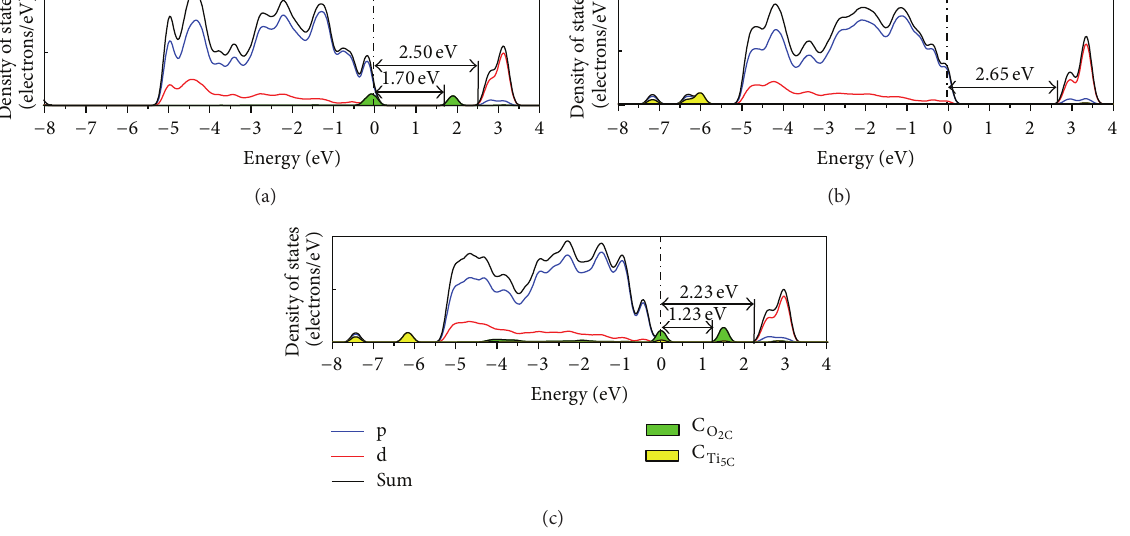
site and that of C dopant at Ti 5 site are C C